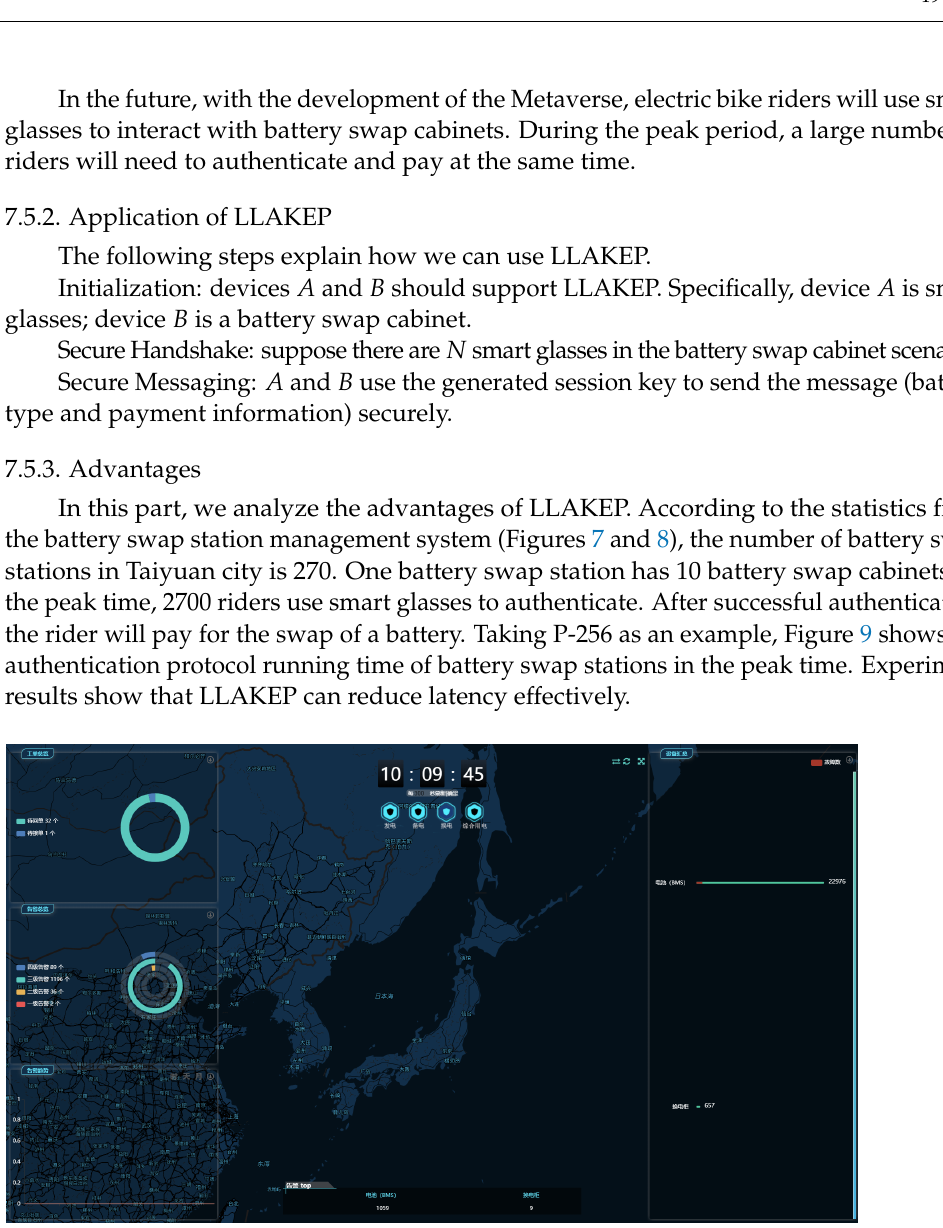
Figure 7. Battery swap station management system. The number of battery swap stations in Taiyuan city can be obtained from this system.